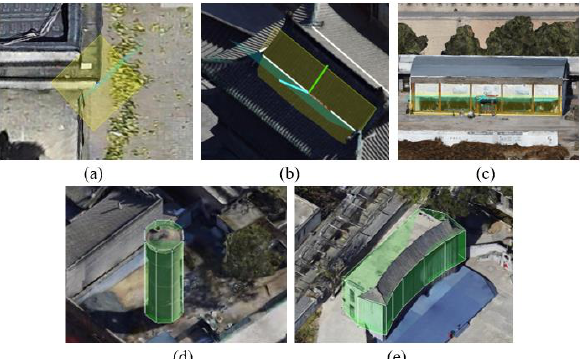
Figure 2 . Illustrations of different geometric classes for object